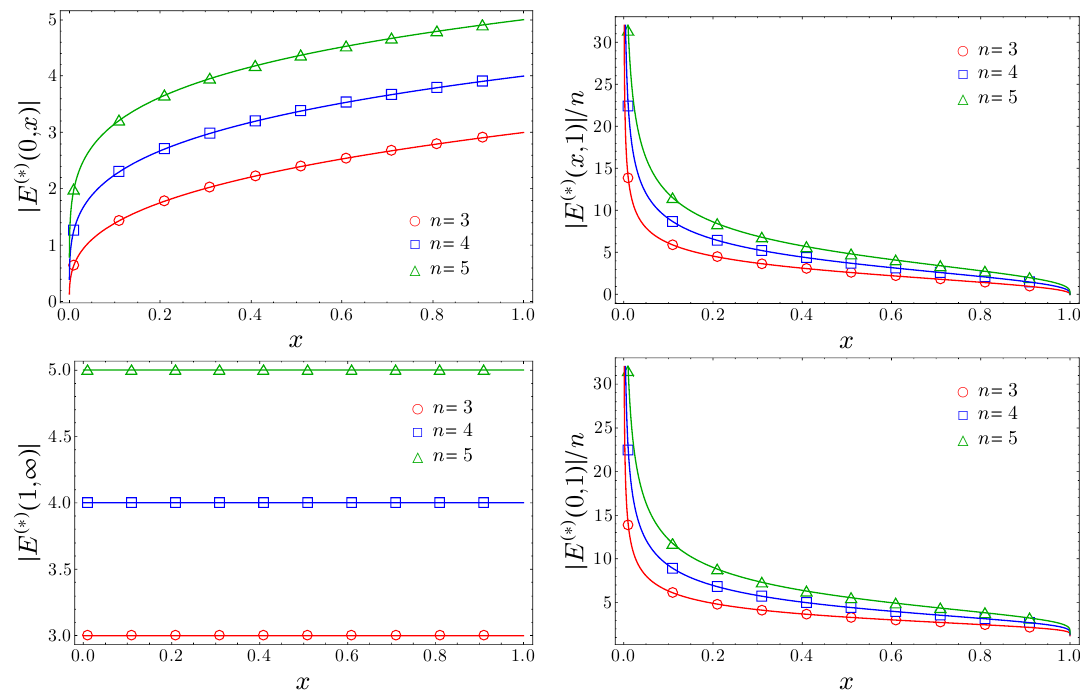
Figure 7 . Numerical check of eqs. (4.32)–(4.35) involving the regularised prime form E ( ∗ ) ( z, z 0 ) . We test them for different values of the genus n − 1 . The points correspond to the direct numerical evaluation of the definition in eq. (4.30) of E ( ∗ ) ( z, z 0 ) . The continuous lines are the plot of the functions on the right hand side of eqs.